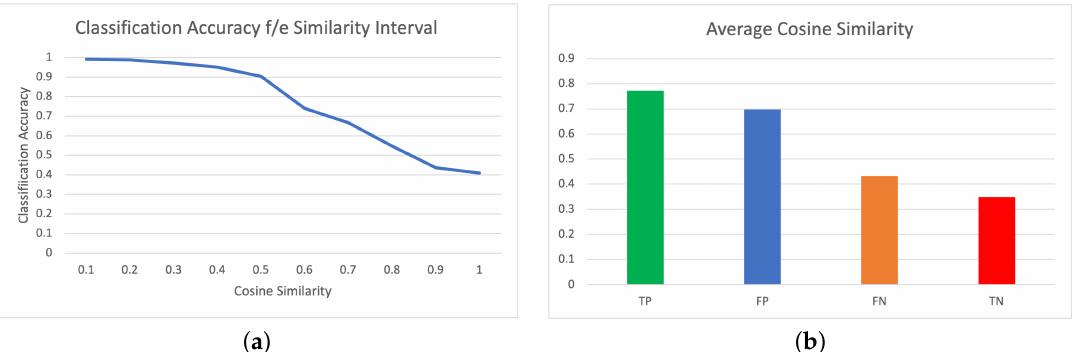
Figure 3. Lexical similarity analysis of the transformer model’s output. ( a ) Average accuracy per similarity interval. ( b ) Average cosine distances for the best-performing model.